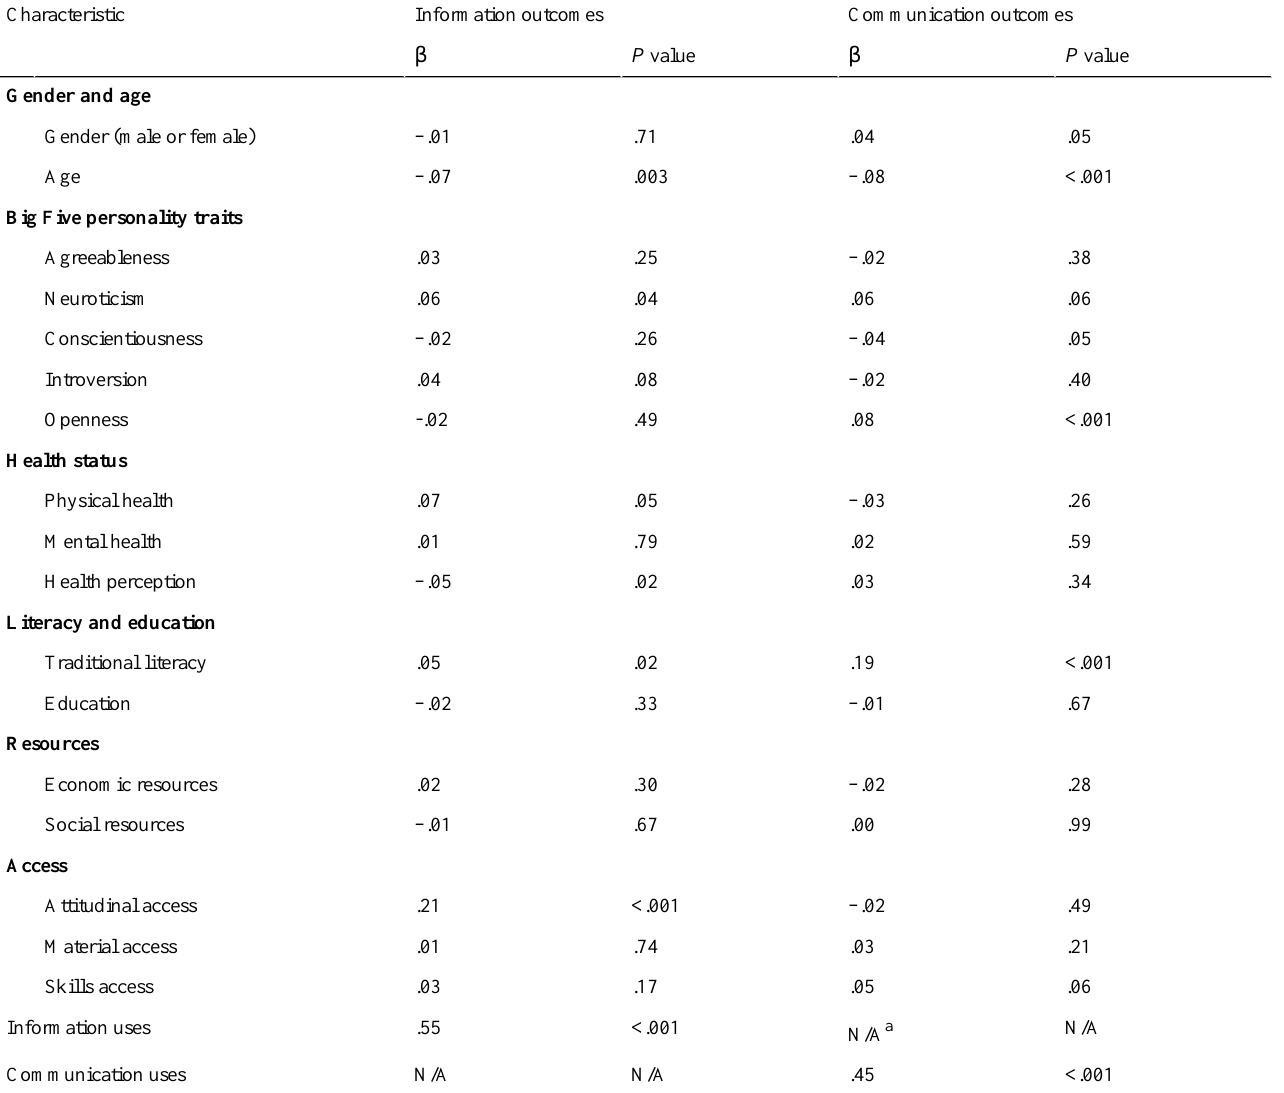
Table 5. Hierarchical regression analysis summary for coronavirus disease–related internet outcomes (Model 2).